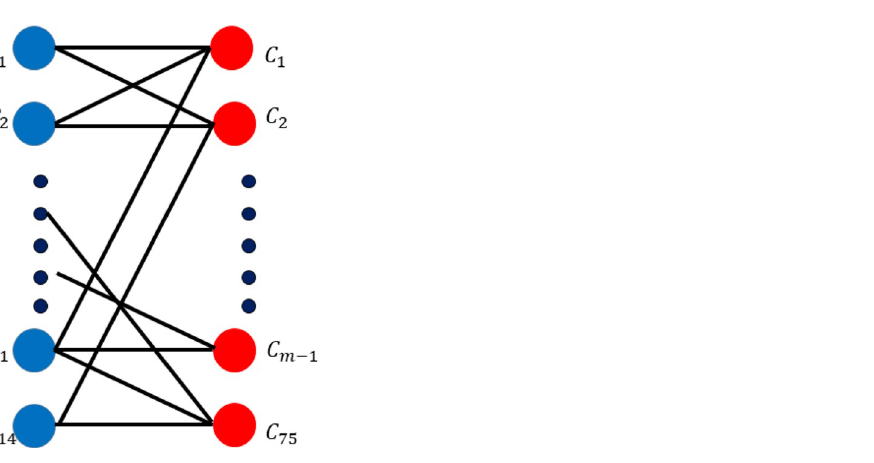
Figure 5. Bipartite graph linking significant clusters and corresponding significant pathways.